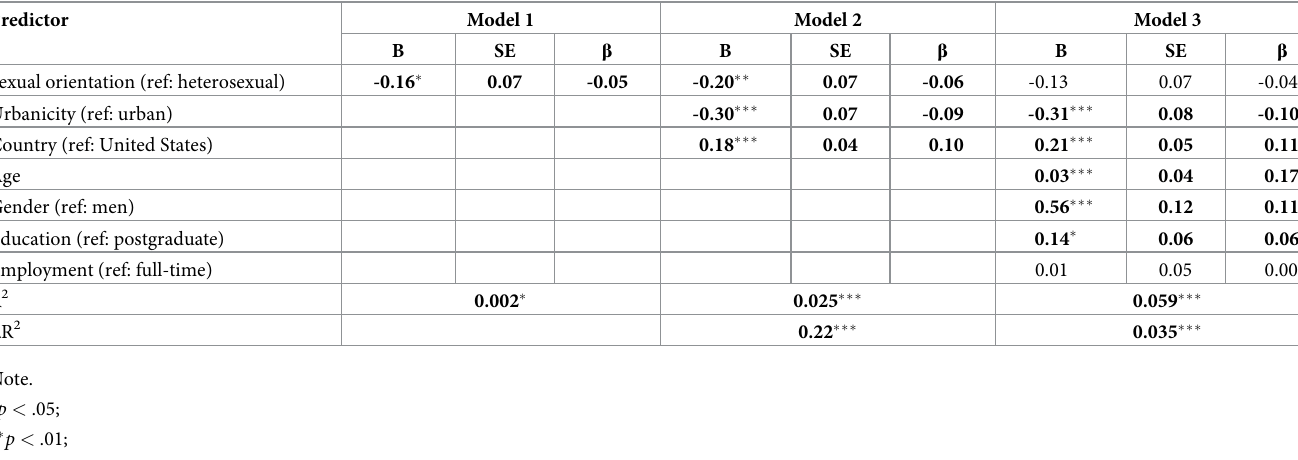
Table 3. Hierarchical linear regression of social distancing on sociodemographic predictors with standardized and unstandardized coefficients.